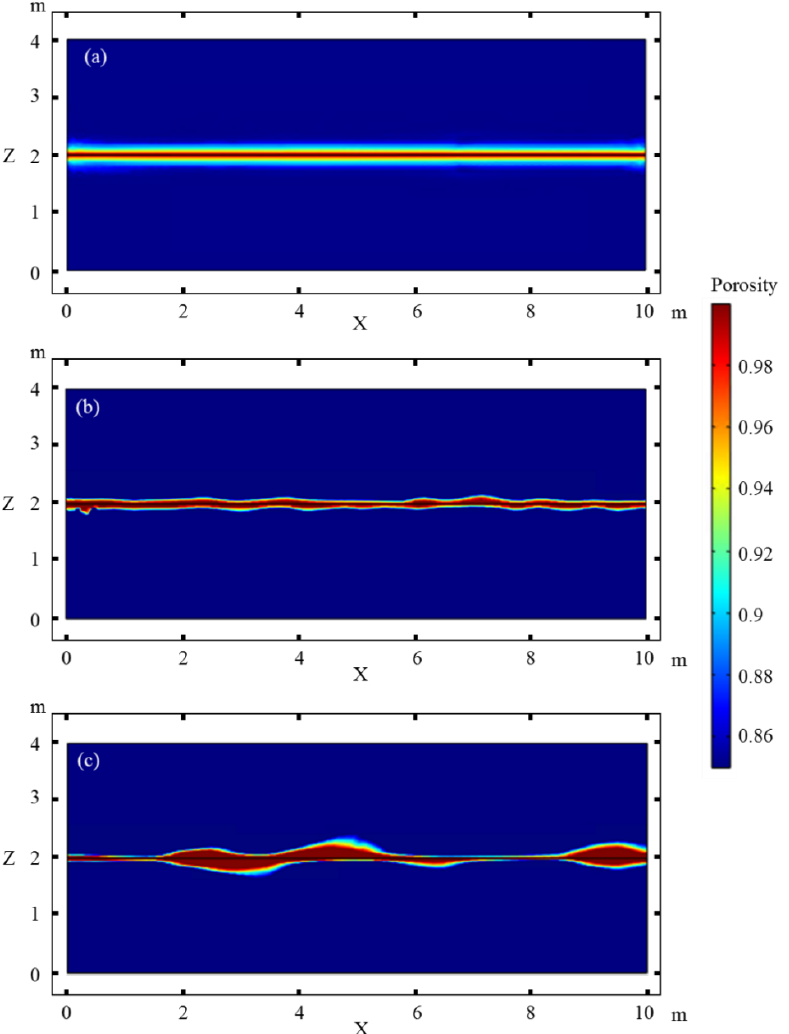
Figure 3. Effect of the magnitude of matrix porosity heterogeneity on the dissolution along the horizontal fracture. ( a ) Homogeneity, ( b ) weak heterogeneity, ( c ) strong heterogeneity.